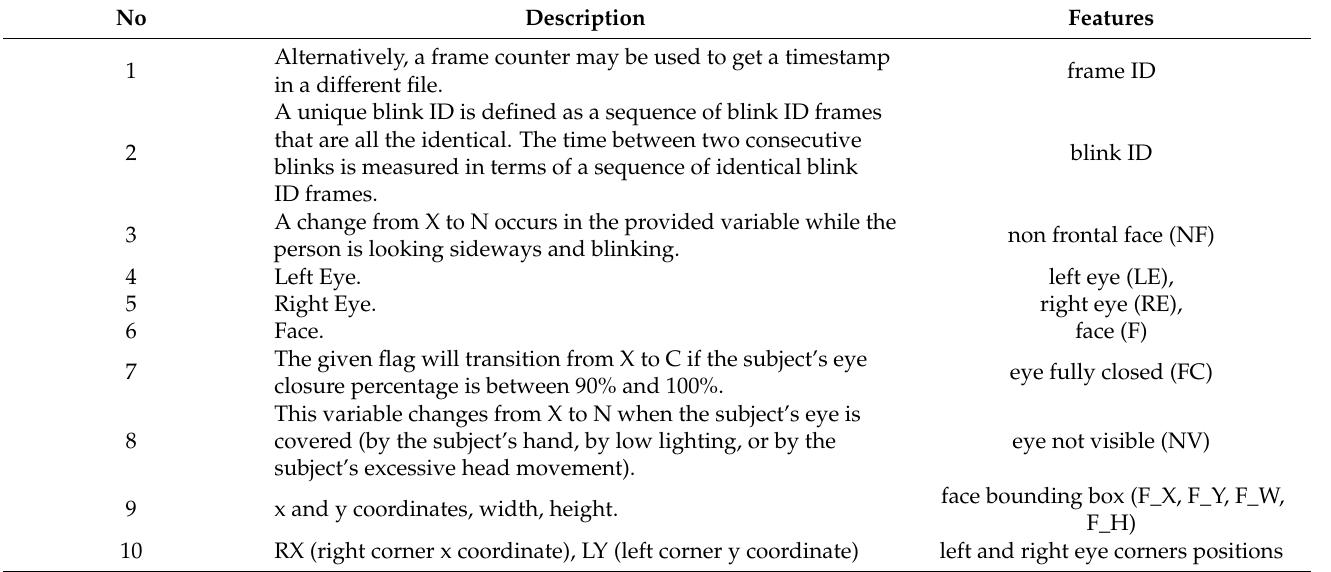
Table 2. Dataset